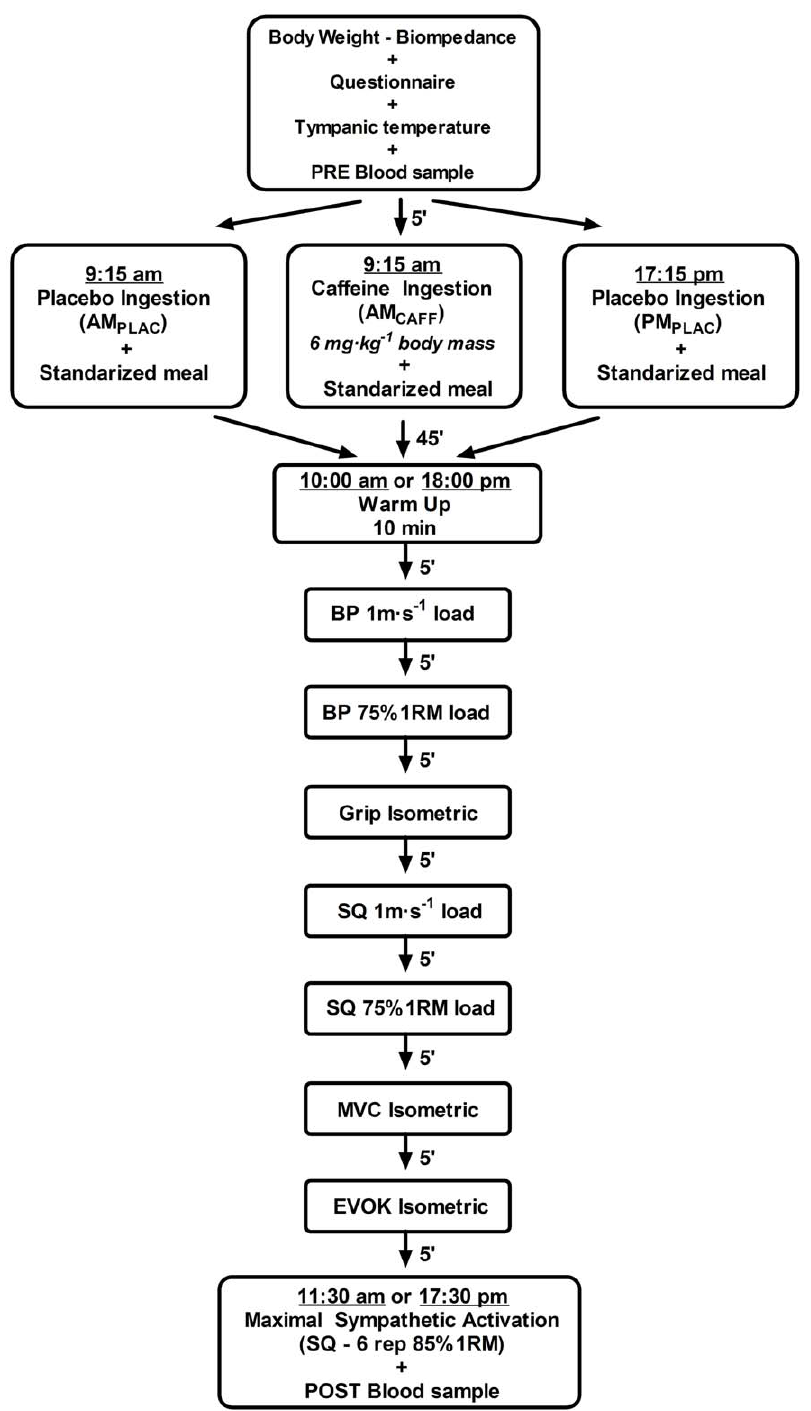
Figure 1. Experimental Protocol. Twelve highly resistance-trained men, in a randomized, double-blind and placebo controlled experimental design, underwent a battery of neuromuscular and biochemical assessments under three different conditions; i ) morning (10:00a.m.) with caffeine ingestion (i.e., 3 mg kg 2 1 ; AM CAFF trial); ii) morning (10:00a.m.) with placebo ingestion (AM PLAC trial); and iii) afternoon (18:00p.m.) with placebo ingestion (PM PLAC trial). doi:10.1371/journal.pone.0033807.g001 Austria) and then spun at 2000 g for 10 min in a refrigerated (4 u C) centrifuge (MPW-350R, Med. Instruments, Poland) to separate A portion of the blood was allowed to clot into serum tubes (Z the serum portion. Serum blood was used to determine total Serum Sep Clot Activator Vacuette H , Greiner Bio-One GmbH, testosterone (TT), cortisol (C) and growth hormone (GH)